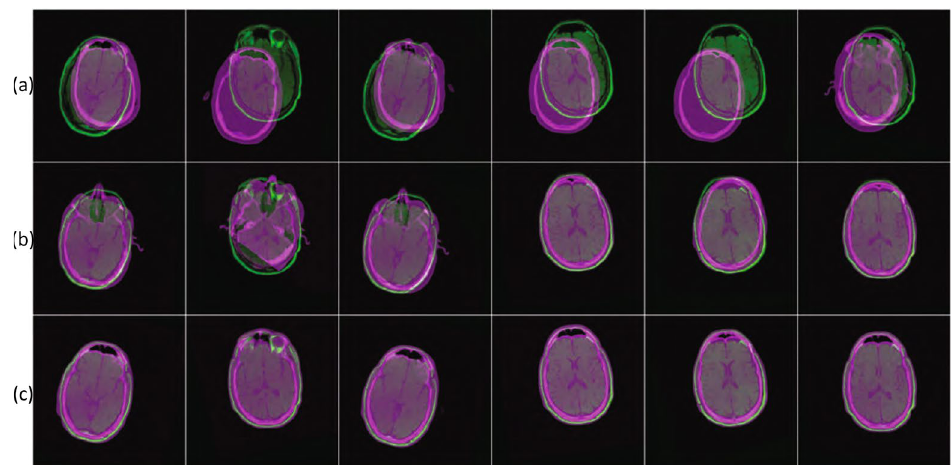
Figure 7. Example of registration without and with symmetry alignment. The rows show: ( a ) the fixed and moving images, ( b ) the results of the mathematical optimisation process without symmetry alignment, and ( c ) the results of the registration with symmetry